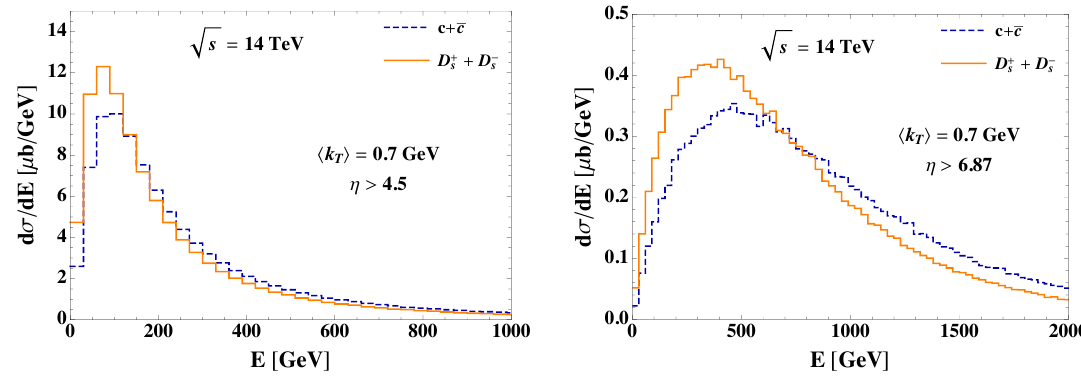
Figure 3 . The e(cid:11)ect of fragmentation of charm quark to D s which shifts the energy distribution to lower energy for both (cid:17) > 4 : 5 (left) and (cid:17) > 6 : 87 (right). Shown are the di(cid:11)erential cross sections of p charm quarks and D s mesons produced in pp collision at s = 14 TeV for ( (cid:22) R ; (cid:22) F ) = (1 : 0 ; 1 : 5) m T and h k T i = 0 : 7 GeV, as a function of the energy E . Note that the D s fragmentation fraction has been set to unity to demonstrate this e(cid:11)ect